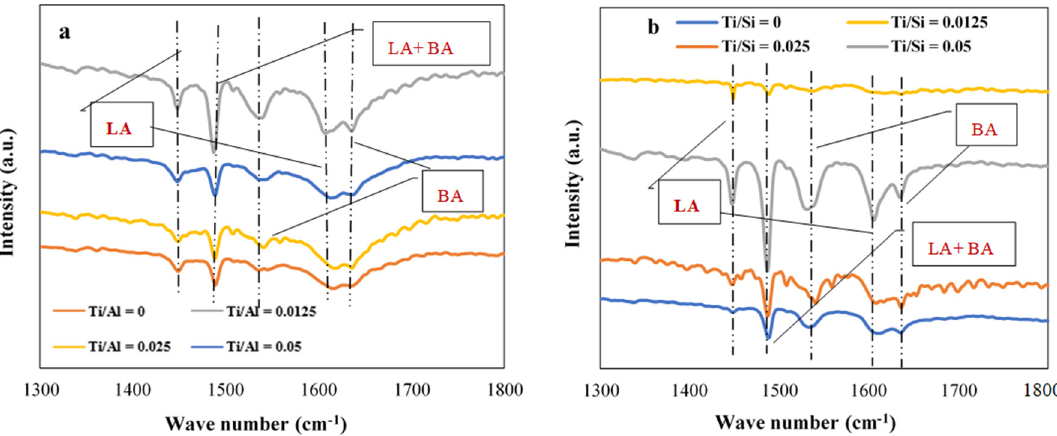
Figure 3. N 2 isotherm of ( a ) HPMo/Ti-Al 2 O 3 and ( b ) HPMo/Ti-TUD-1 catalysts. The NH 3 temperature-programmed desorption study was carried out to quantify the total acidity of HPMo/Ti-TUD-1 and HPMo/Ti-Al 2 O 3 catalysts. The total acidity of each catalyst is given in Table 3. In each series, the amount of acid sites is gradually increasing with an increase in the Ti content of catalysts. Lewis and Brønsted acidic sites of catalysts were determined by pyridine FTIR analysis and spectra are shown in Figure 4. Pyridine adsorption on HPMo/Ti-Al 2 O 3 and HPMo/Ti-TUD-1 series results in bands at 1448, 1539, 1488 cm − 1 , which are characteristic of Lewis acid (LA), Brønsted acid (BA), and overlap of Brønsted and Lewis acid sites, respectively [34]. The pyridine FTIR study confirms that HPMo/Ti-Al 2 O 3 and HPMo/Ti-TUD-1 catalysts contain both Brønsted and Lewis acid sites.